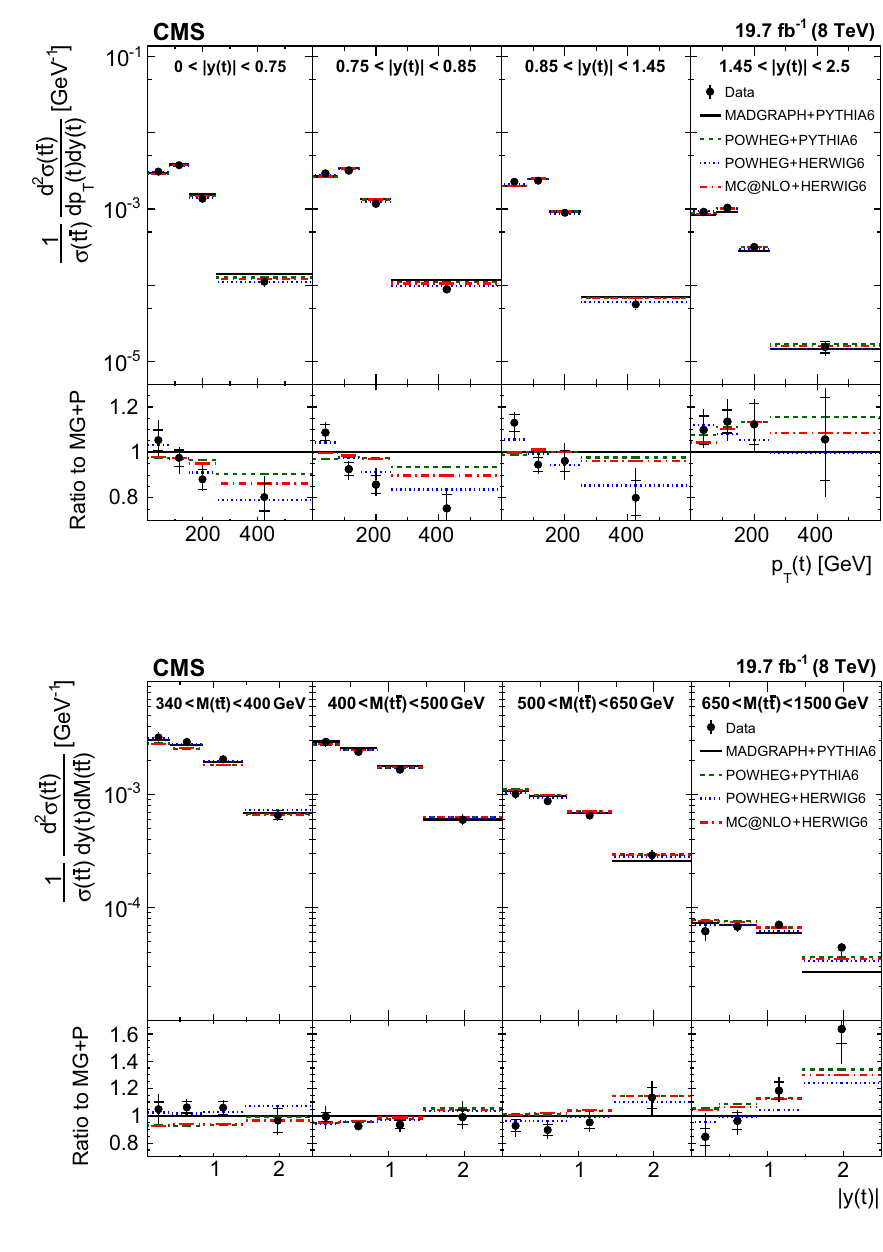
measured normalized tt double-differential cross section as a function of p T ( t ) in different | y ( t ) | ranges to MC predictions calculated using MadGraph + pythia 6, powheg + pythia 6, powheg + herwig 6, and mc@nlo + herwig 6. The inner vertical bars on the data points represent the statistical uncertainties and the full bars include also the systematic uncertainties added in quadrature. In the bottom panel , the ratios of the data and other simulations to the MadGraph + pythia 6 (MG+P) predictions are shown